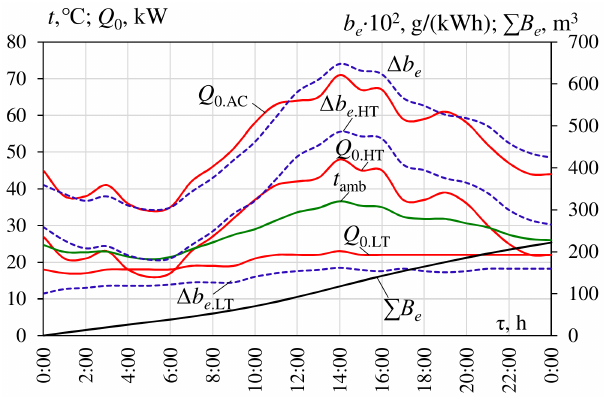
Figure 10. Daily variation of thermal loads Q 0.HT and Q 0.LT on high- and low-temperature air coolers and Q 0.AC on the whole two-stage air cooler; Q 0.HT and decreases of specific fuel consumption ∆ b ∆ b ∆ b e , accordingly, and summarized volume gas-saving e.HT , e.LT , of Ukraine, 2017).